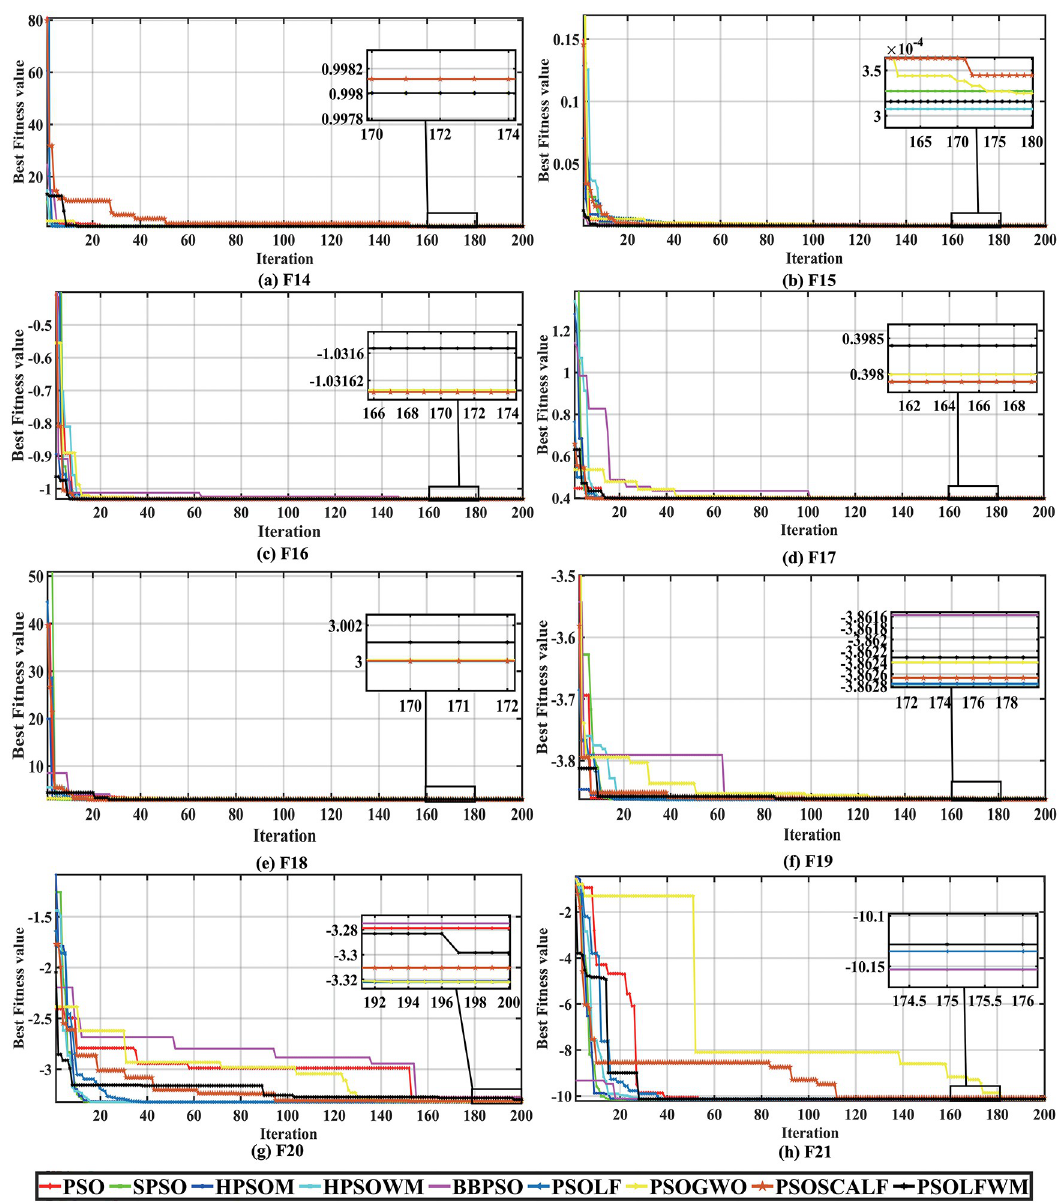
Fig 3. Convergence curve of others functions compared with the PSO family algorithms. (a) F14, (b) F15, (c) F16, (d) F17, (e) F18, (f) F19, (g) F20, and (h)